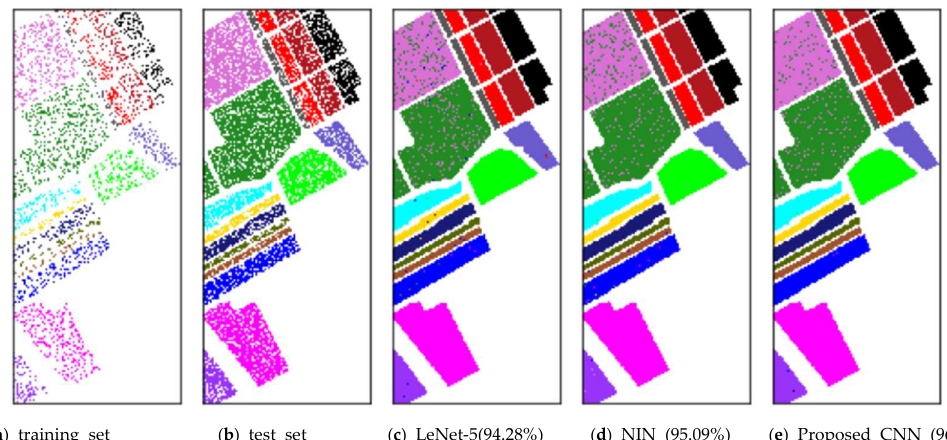
Figure 16. Classification maps of different CNN architectures on the Salinas dataset.